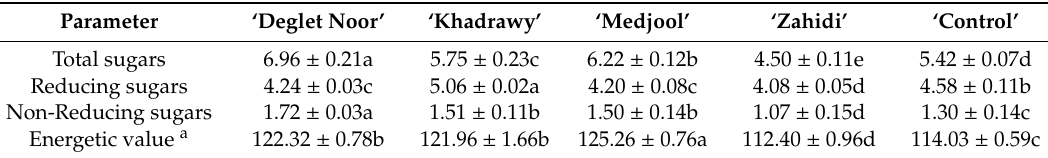
Table 4. Sugar content and energy content of ‘Medjool’ date seeds obtained from fruit resulting from pollination using pollen from ‘Deglet Noor’, ‘Khadrawy’, ‘Medjool’, and ‘Zahidi’ cultivars. Control is a pollen mixture from random date palm male plants used by the grower. All parameters are expressed in g / 100 g dry weight.